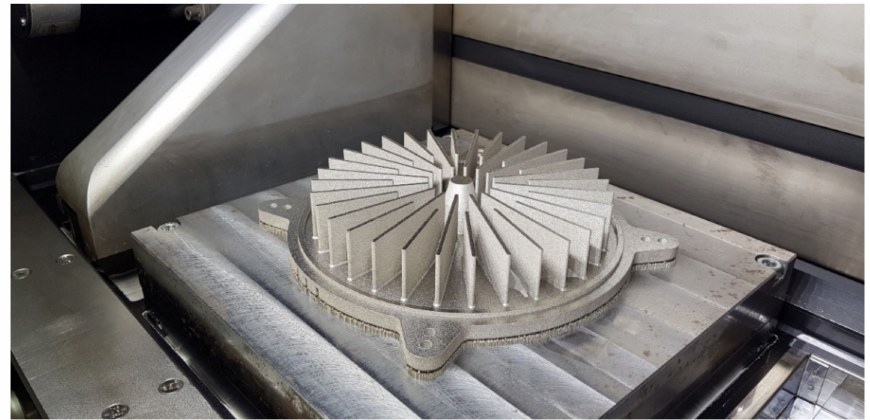
Figure 32. Radiator in the workspace of the EOS M270 variant No.